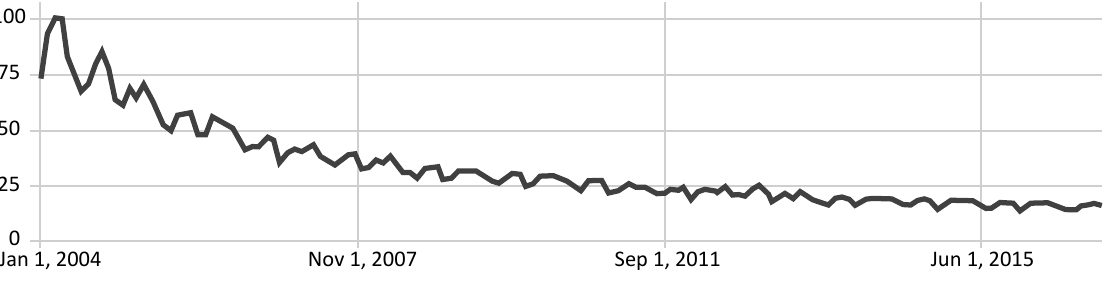
Figure 2. Interest in “outsourcing” over